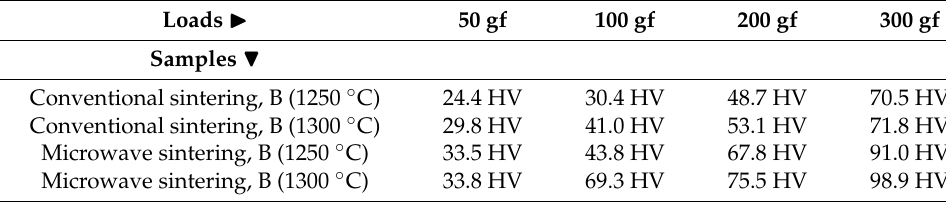
Table 5. Microhardness of the microwave and conventionally sintered